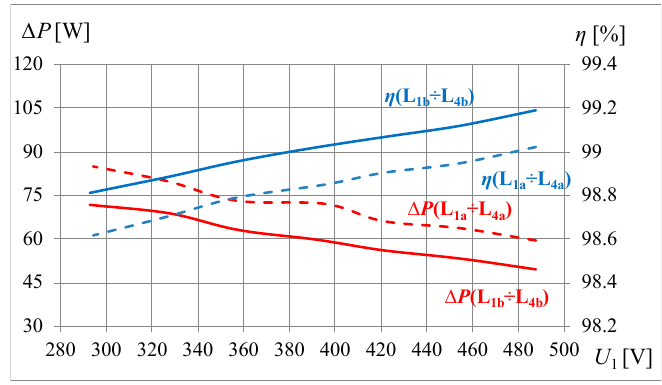
Figure 13. Power losses ( Δ P) and efficiency ( η ) versus input voltage (duty cycle) obtained at f s = 125 kHz, P n = 6 kW, with use of different types of input inductors: L 1a – L 4a (dotted lines) or L 1b – L 4b (solid lines).